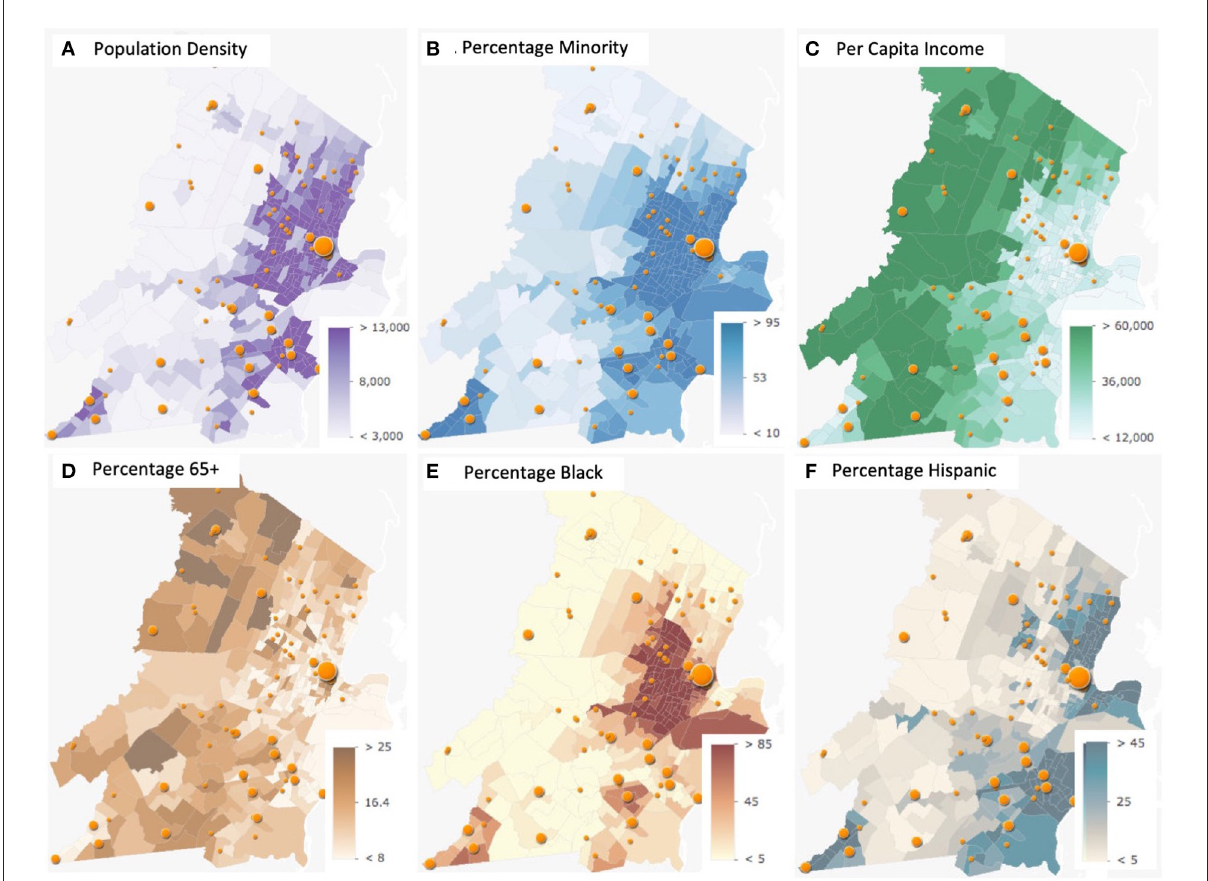
FIGURE2 Spatial distributions of socioeconomic variables. (A) Population density; (B) Percentage minority; (C) Per capita income; (D) Percentage 65 + ; (E) Percentage black; (F) Percentage